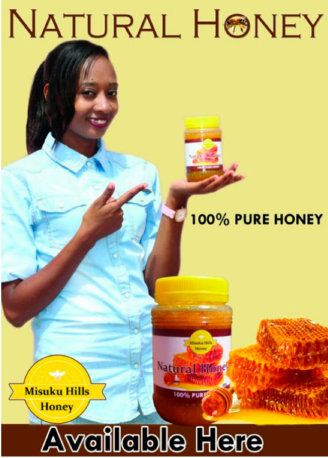
Figure 3. Misku Hills Honey. Source: Sustainable Development Initiative.